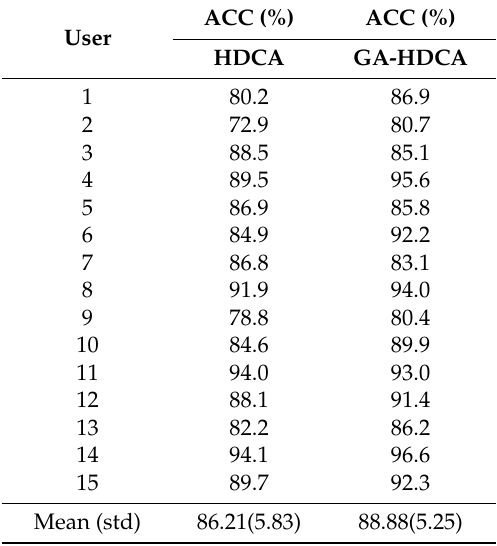
Table 2. The classification accuracy of each user with a 30-day averaged time interval.